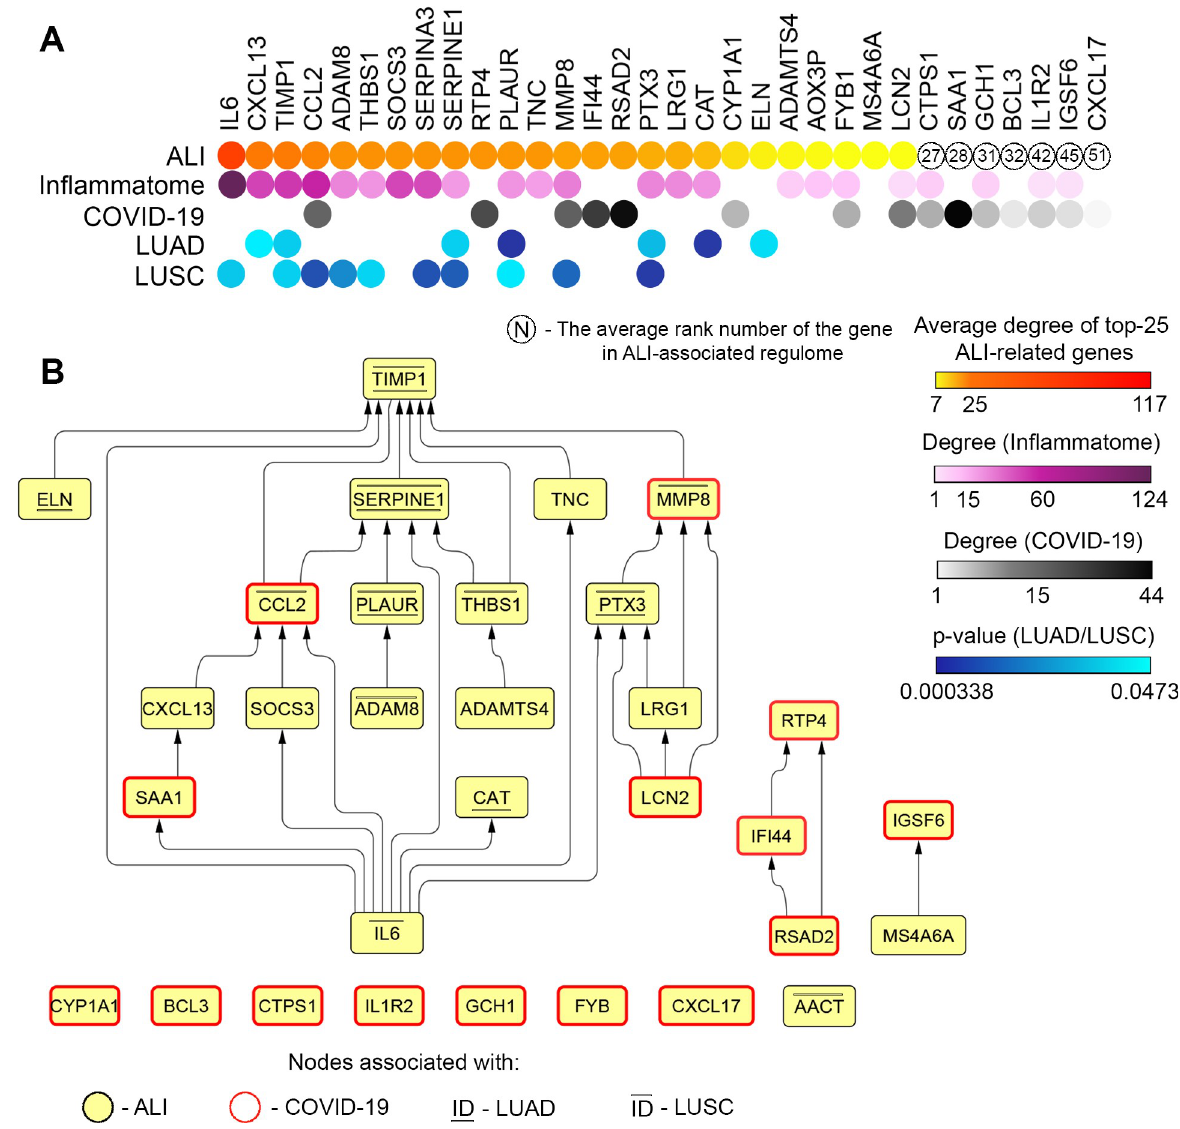
Fig 5. Interconnections and interplay of revealed key ALI-associated genes in different pulmonary disorders. (A) The heatmap showing interconnections of revealed ALI-associated key genes with the rodent inflammatome, the COVID-19 regulome, and the progression of lung cancer in patients. Degree: the number of linkages of the gene with partner genes within the gene association network. In the case of LUAD/LUSC, only those genes are marked in which the expression level is significantly and negatively associated with overall survival time for patients with lung cancer. (B) The hierarchical network reconstructed with all revealed key regulatory genes involved in ALI development (STRING, confidence score � 0.7).